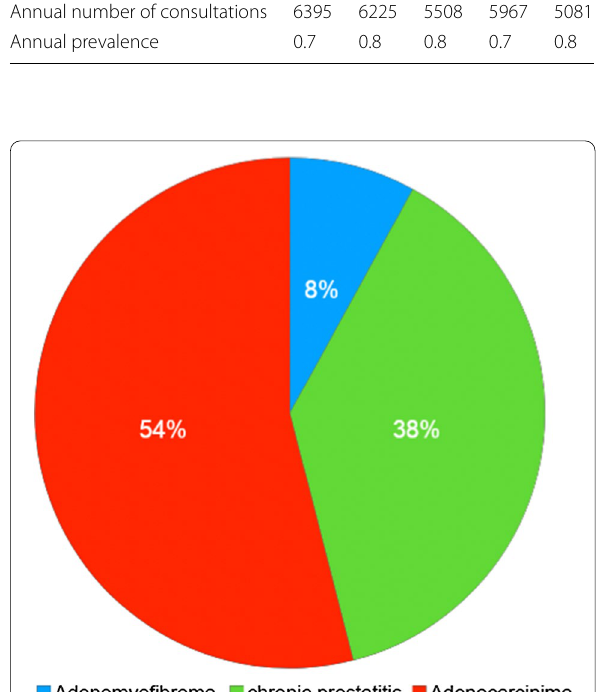
Fig. 1 Distribution of pathology results of patients who underwent transrectal ultrasound-guided prostate biopsy ( n